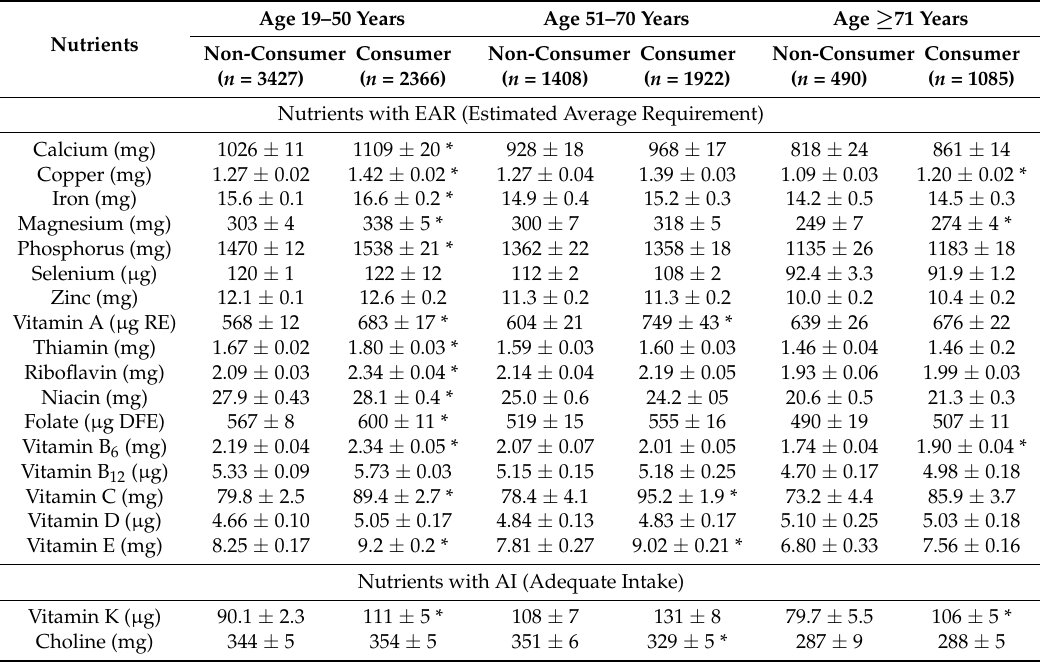
Table 1. Usual intake of nutrients from foods only among adults (19+ years old) by age groups. NHANES 2009–2012, gender combined data.